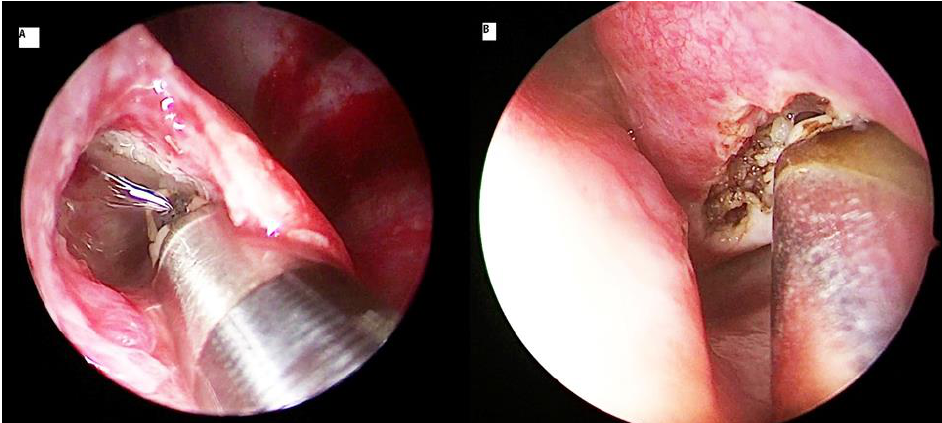
Figure 4. Coblation turbinoplasy applied as an intraturbinoplasty technique ( A ) and extraturbinoplasty technique ( B ).